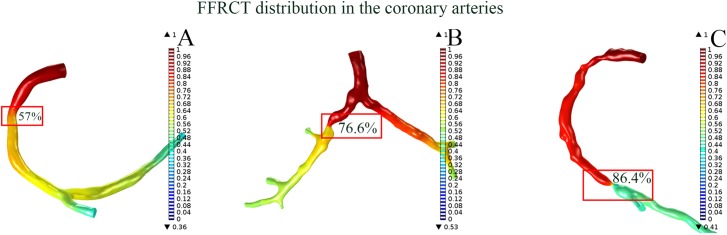
The FFRCT distribution in the coronary arterial geometries with stenosis.The FFRCT at the stenosis decreased as the severity of the stenosis increased. Degree of the stenosis in A, B and C was 57%, 76,6% and 86.4%, the corresponding FFRCT value was 0.687, 0.603 and 0.57, respectively.